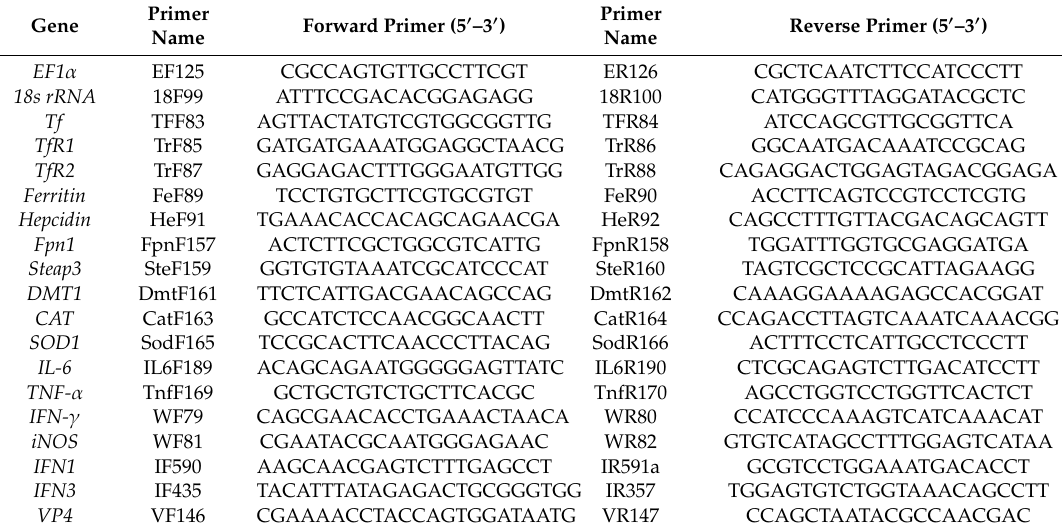
Table 1. Primers for real-time quantitative PCR (RT-qPCR)